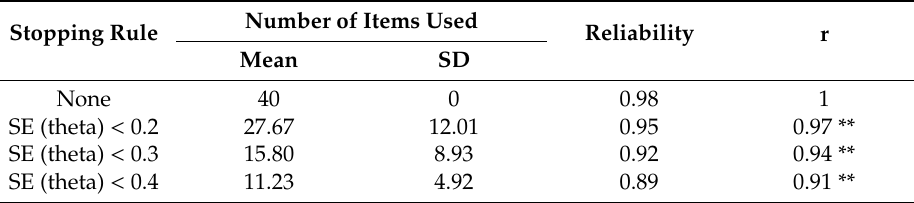
Table 3. Reliability